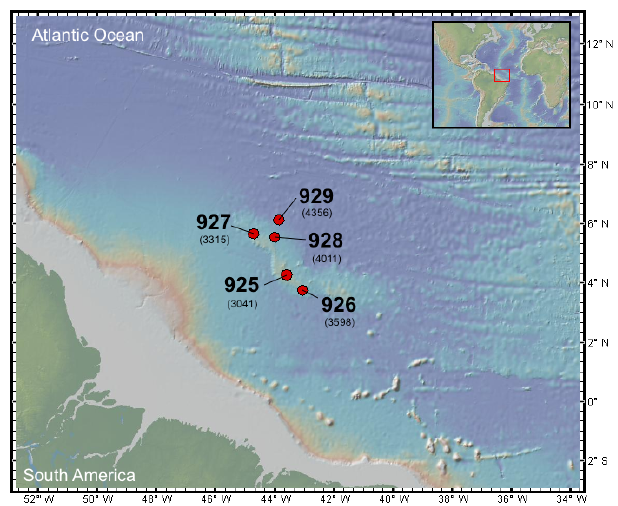
Figure 1. The location of ODP Leg 154